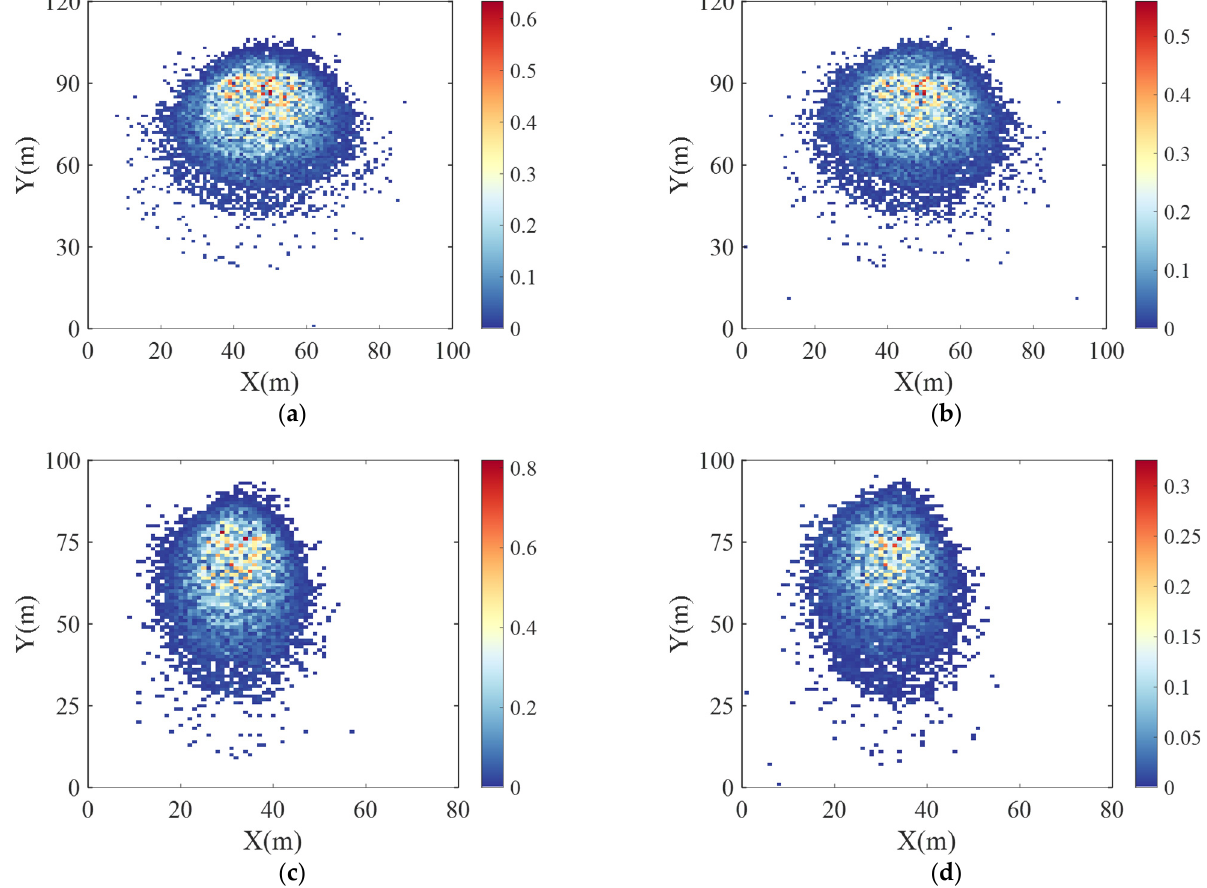
Figure 13. Spatial distribution of chaff cloud echoes at different observation angle. ( a ) 30 , HH polarization; ( b ) 30 , VV polarization; ( c ) 60 , HH polarization; ( d ) 60 , VV polarization.